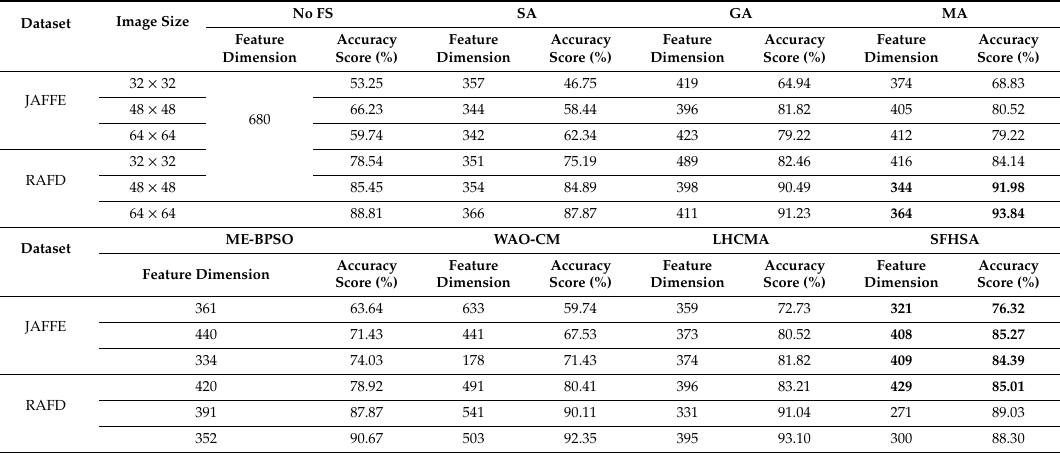
Table 7. Performance of SFHSA with respect to No FS, SA, GA, MA, ME-BPSO, WAO-CM and LHCMA for PHOG